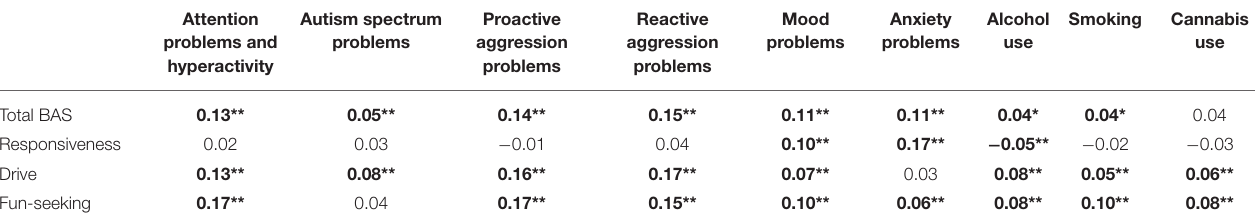
TABLE 1 | Correlations between total BAS and subscale mean scores and psychopathology domain scores at baseline.